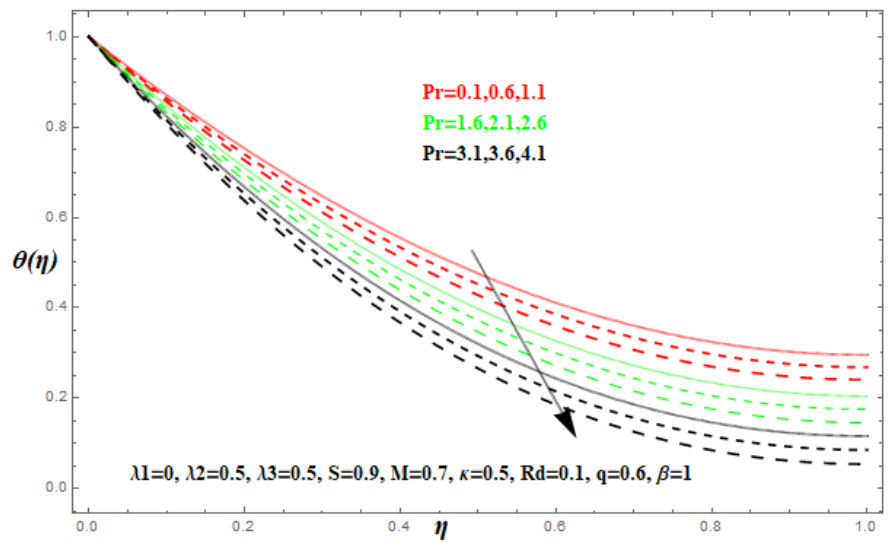
Figure 12. Changes in temperature gradient 𝜃(𝜂) for diverse measures of 𝑃𝑟 .